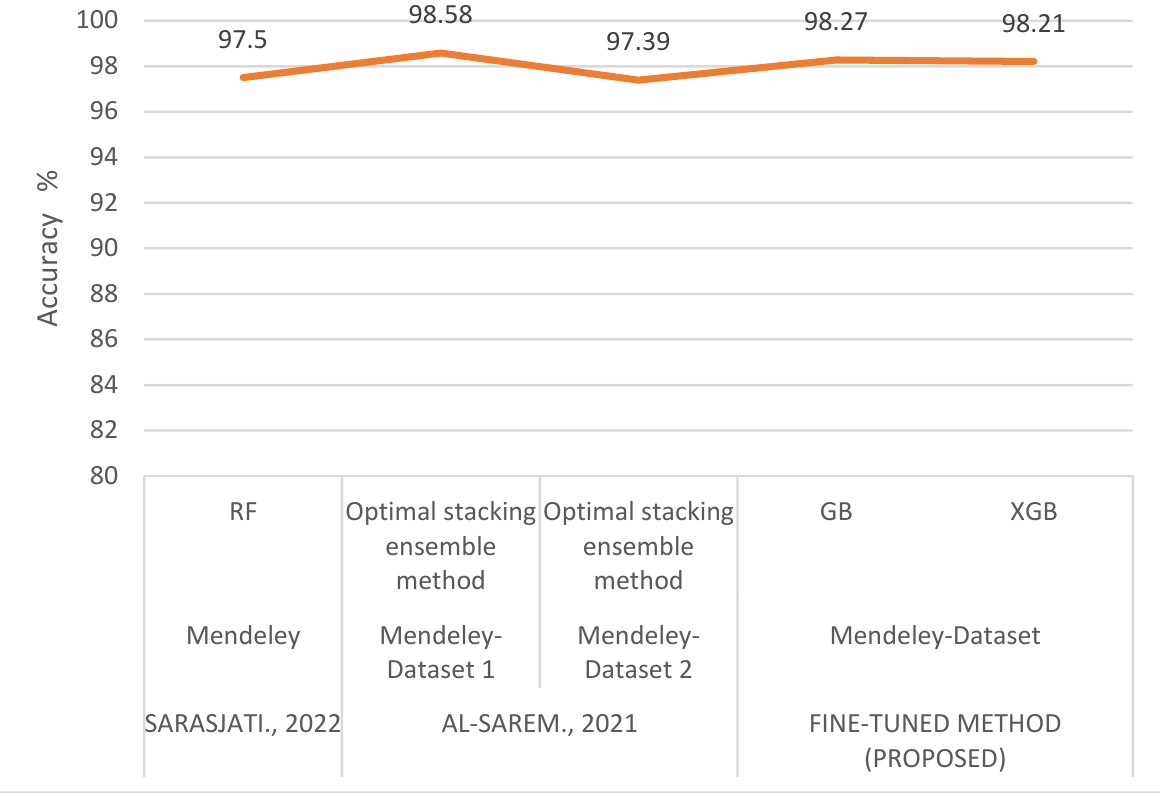
Figure 11. Performance comparison of existing and fine-tuned method for Mendeley dataset [16,19].